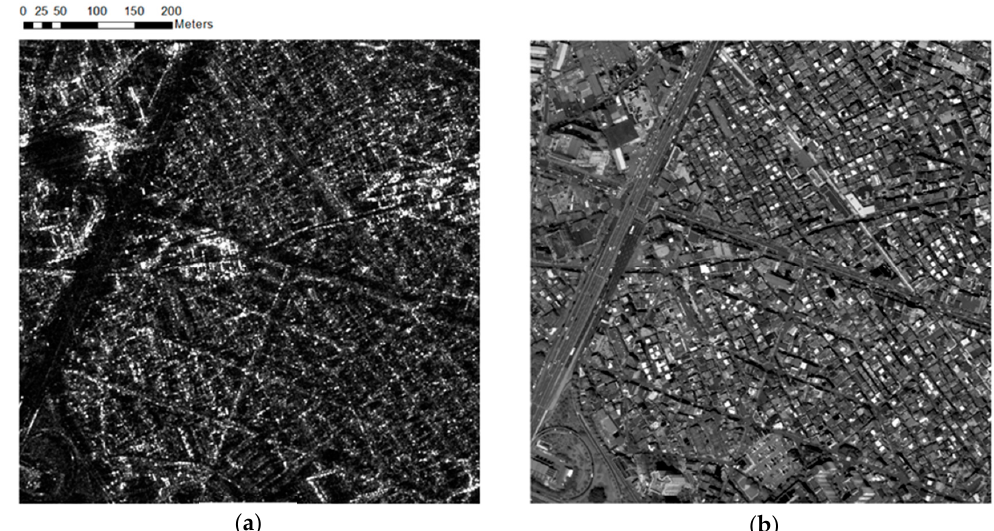
Figure 4. Experimental images from Site 3: ( a ) synthetic aperture radar image acquired on 10 September 2015; and ( b ) panchromatic image acquired on 7 August 2015.